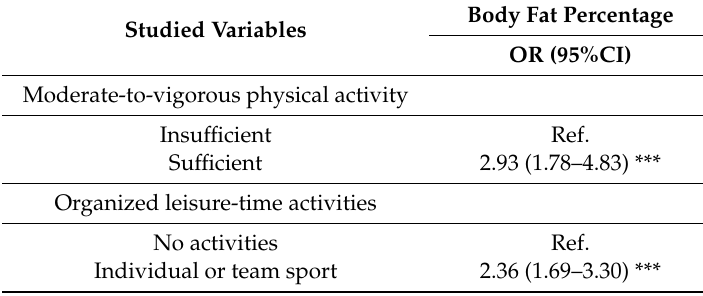
Table 2. The association of organized leisure-time activities and moderate-to-vigorous physical activity with body fat percentage, adjusted for age and gender (odds ratios—OR / 95% confidence interval—95%CI).